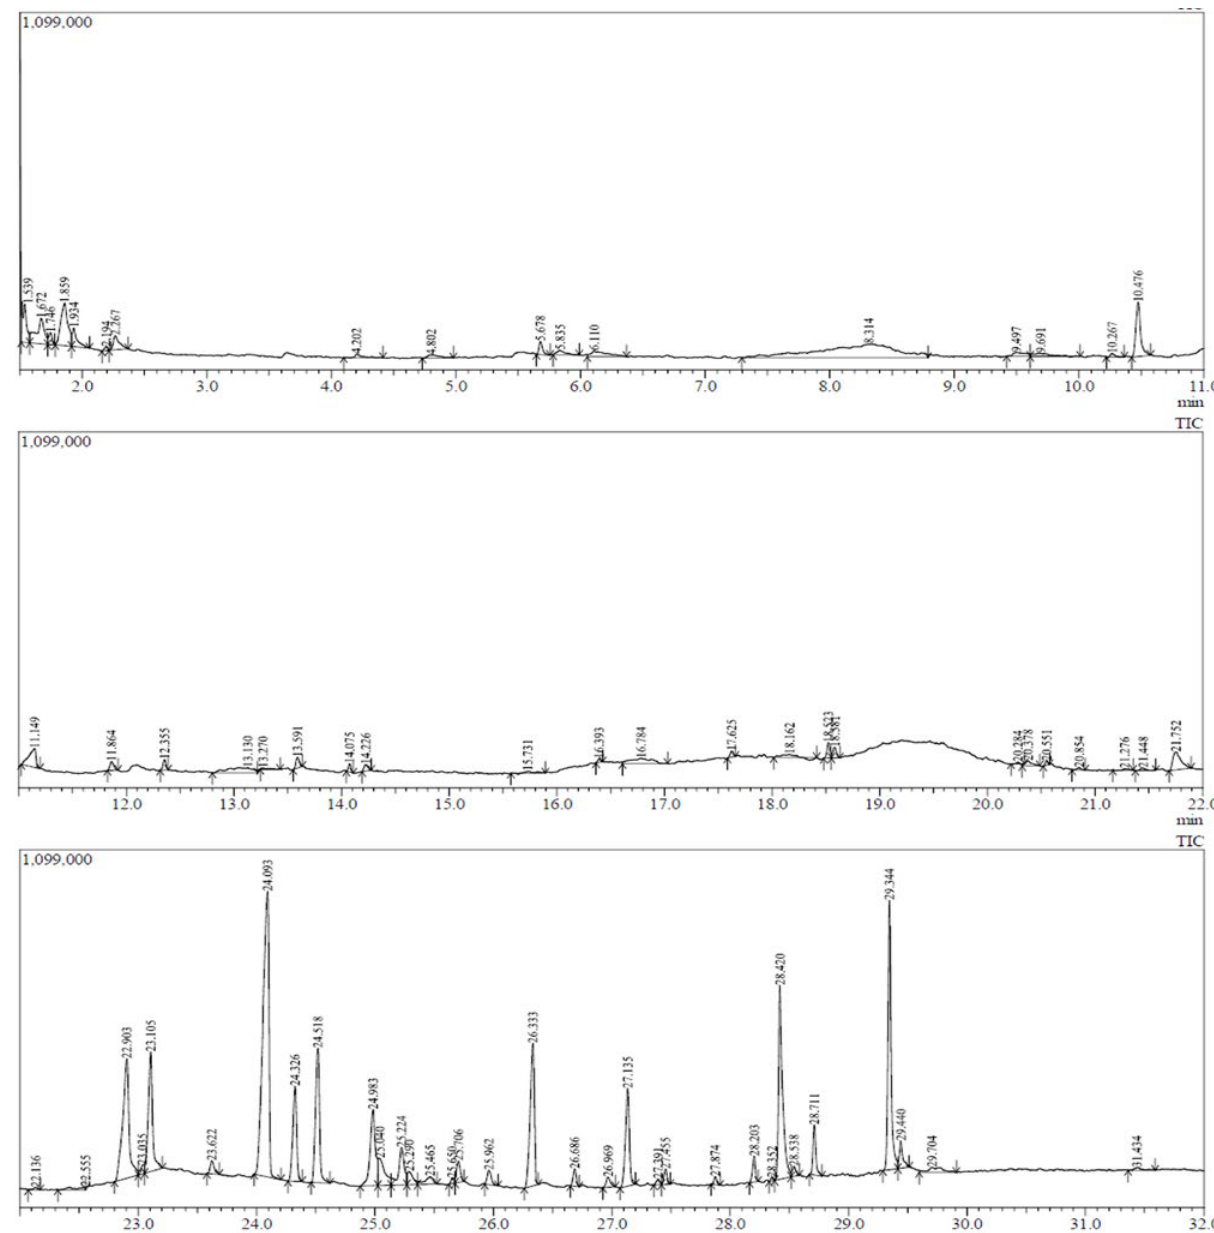
Figure 2. GC-MS chromatogram of the chemical constituents of the khella methanol